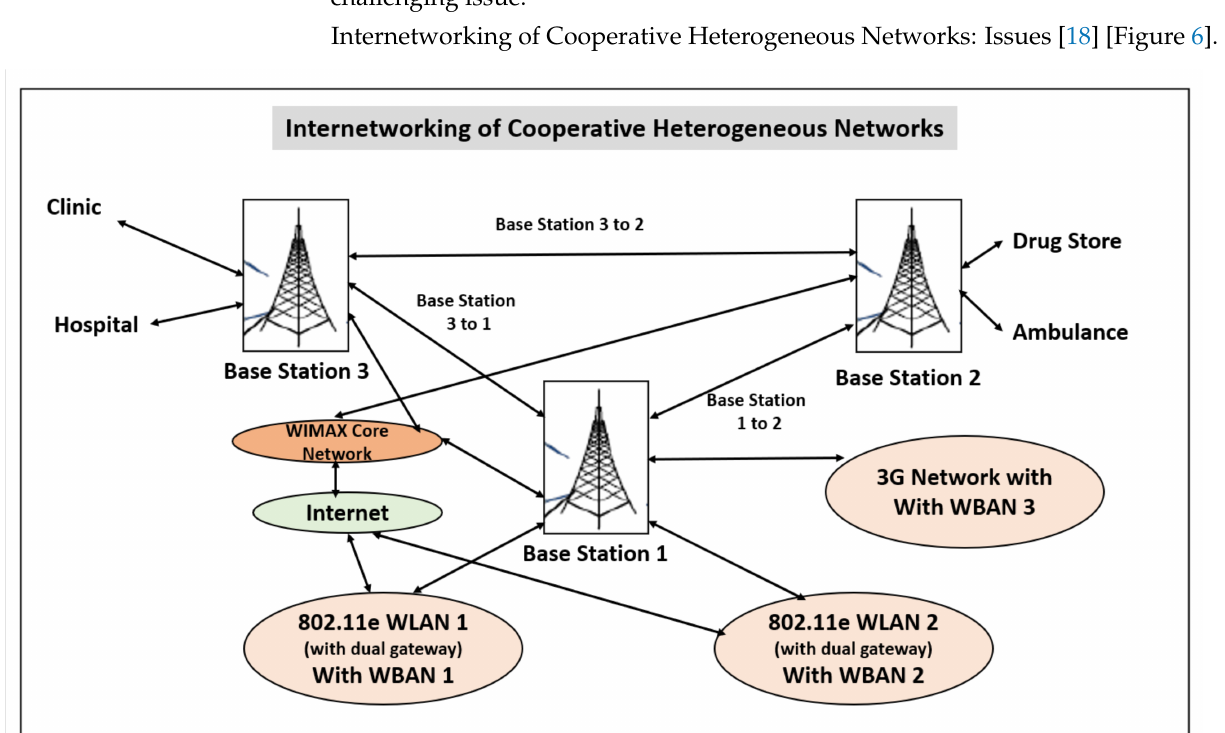
Figure 6. Internetworking of cooperative heterogeneous